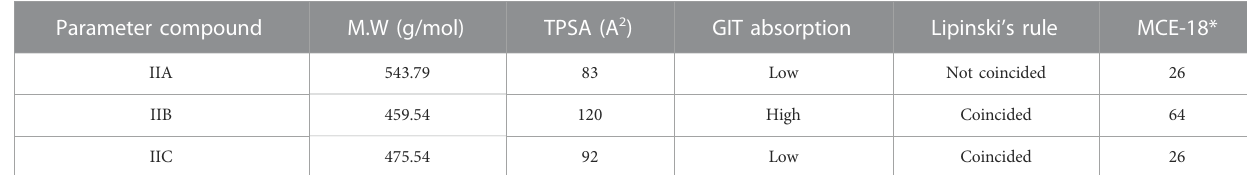
TABLE 3 ADMET properties.